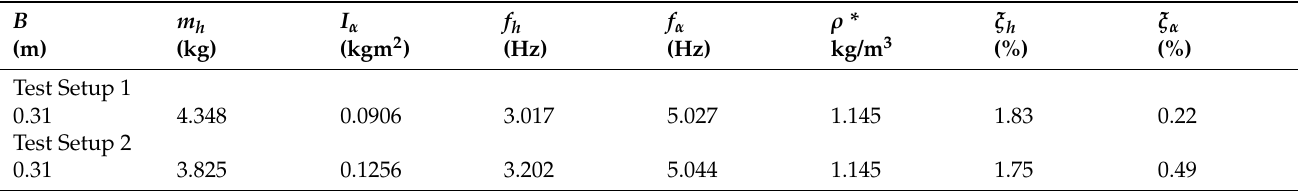
Table 3. Experimental parameters for wind-off case from 2DOF tests.